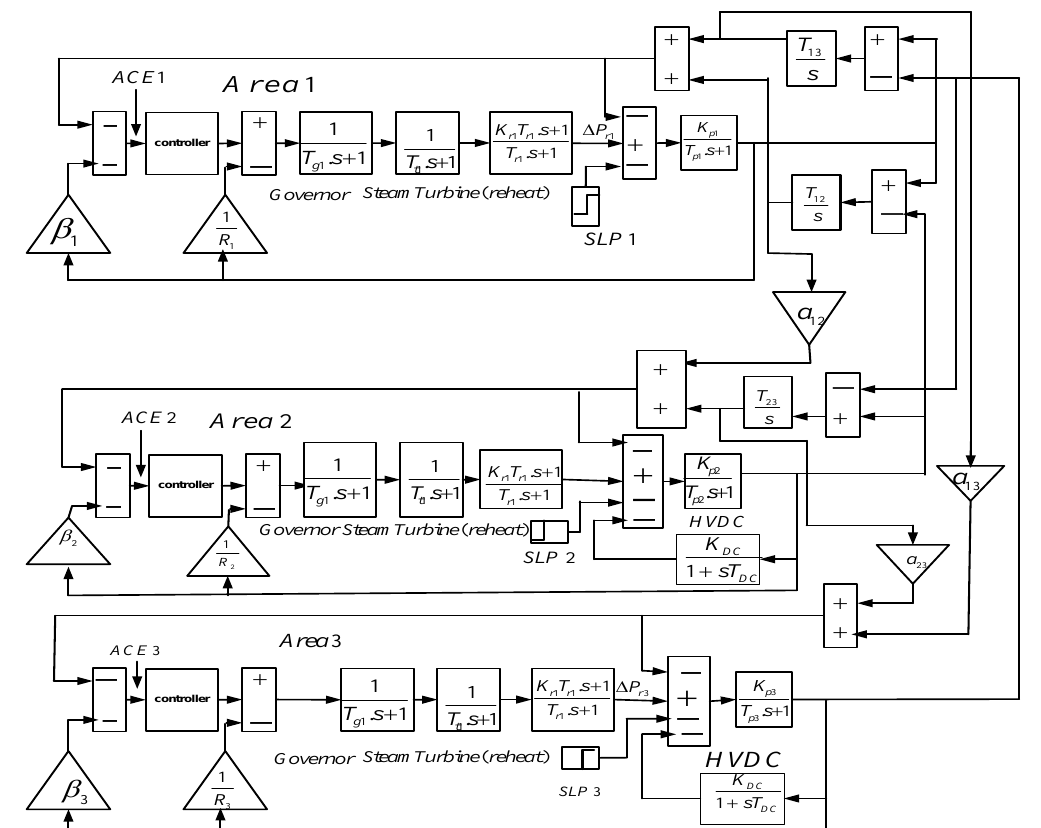
Figure 1. Three-area interconnected thermal power system with an HVDC link in area 2 and area 3.